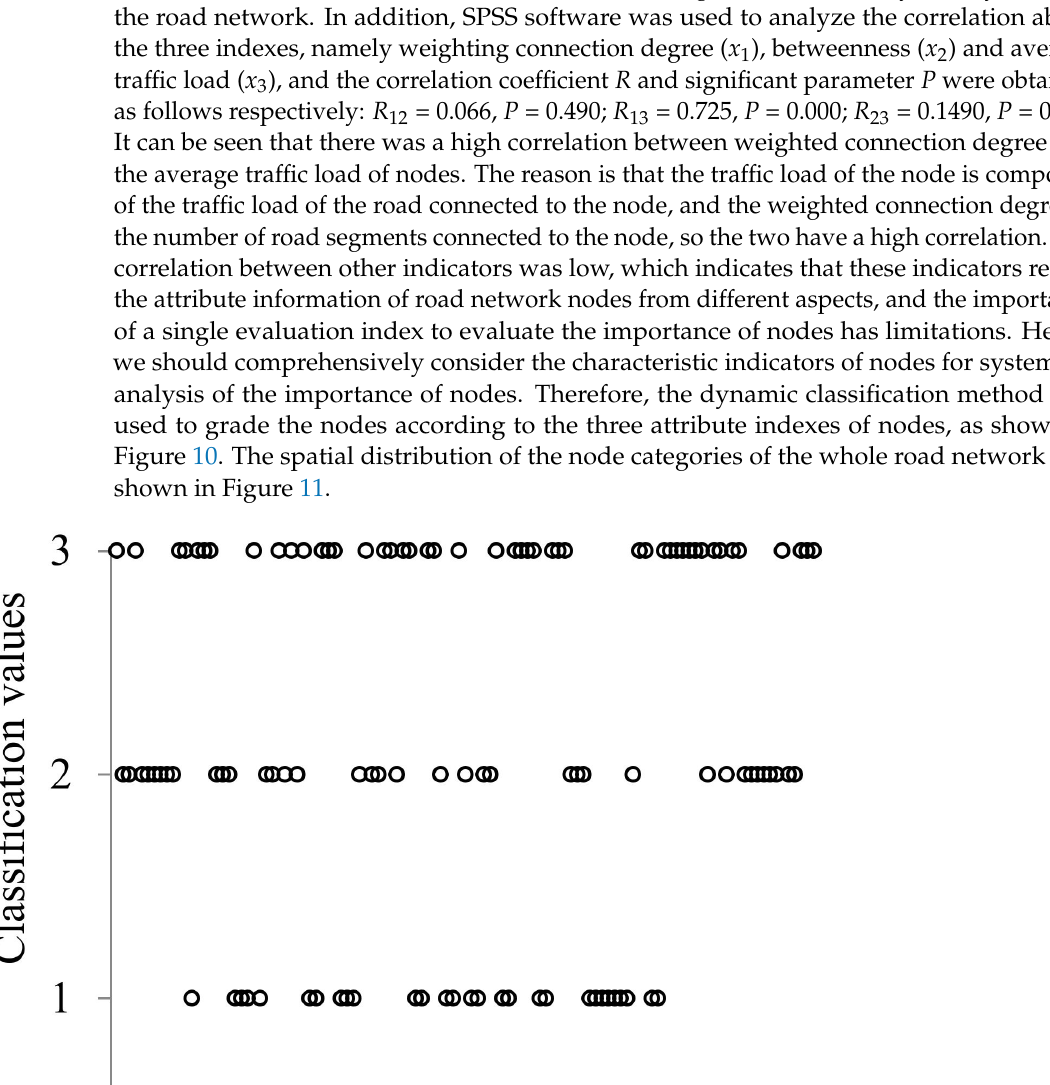
Figure 10. Clustering results of